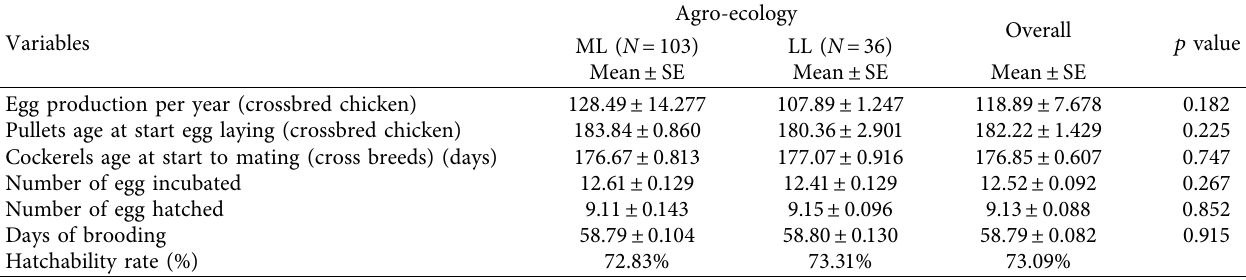
Table 3: Reproductive and productive performances of crossbred chicken.